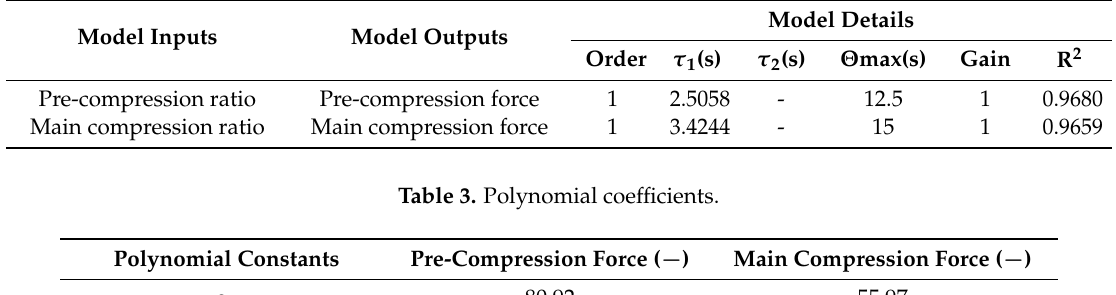
Table 2. Model parameters—Critical process parameters.